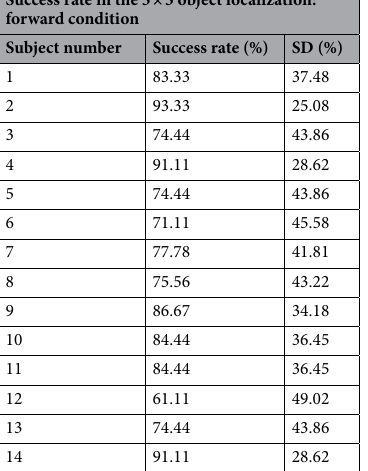
Success rate in the 3 × 3 object localization: forward